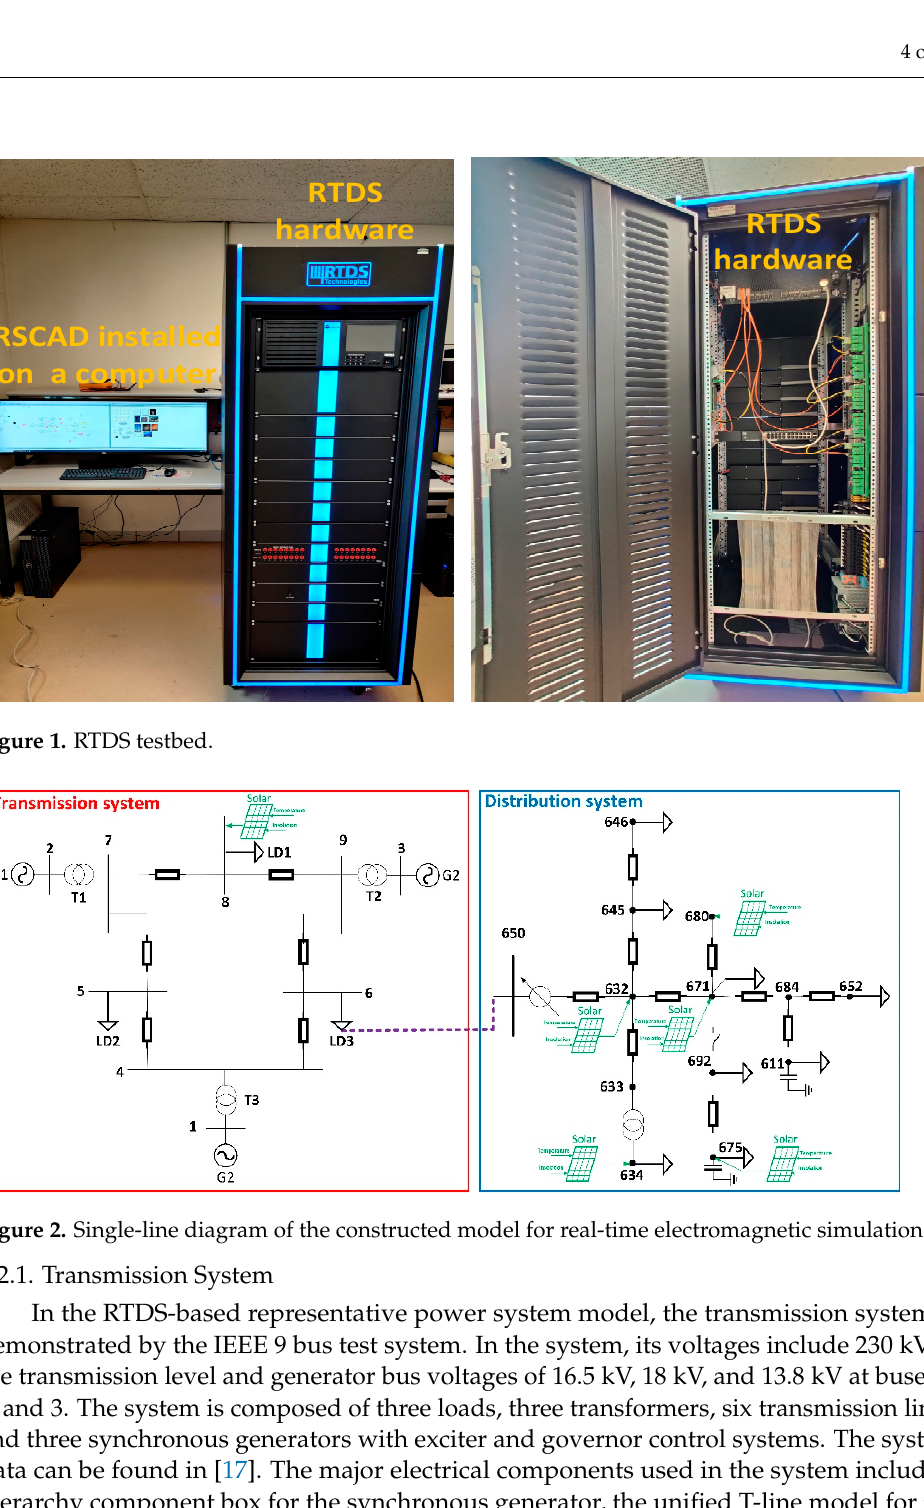
Figure 2. Single-line diagram of the constructed model for real-time electromagnetic simulation.